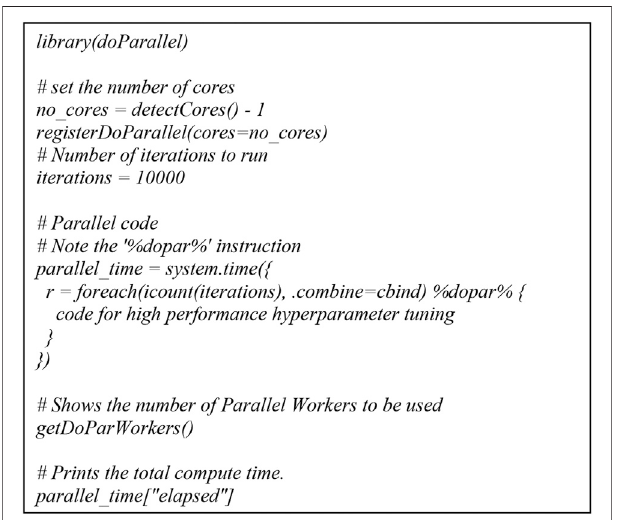
FIGURE 4 | R script for parallel computing.